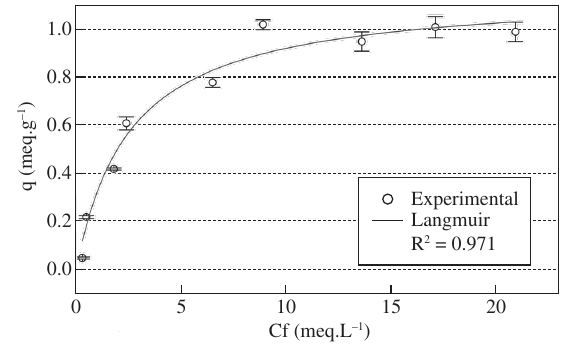
Figure 8. Zeta potential of the activated zeolite (Na-Z), functionalised zeolite (FZ) with barium ions (Ba-FZ) and cooper ions (Cu-FZ). Experimental error: Na-Z ( ± 0.7 mV), Ba-FZ ( ± 0.8 mV), Cu-FZ ( ± 1.3 mV).